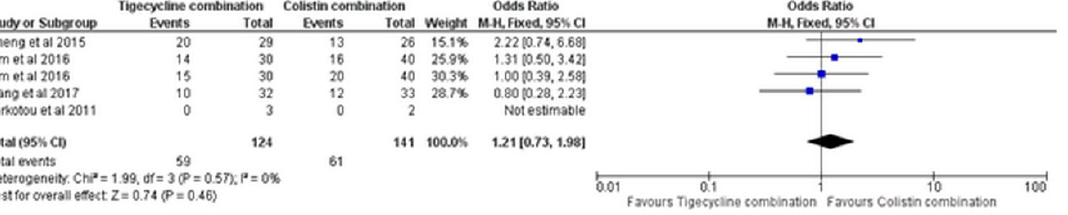
Figure 12. In-hospital mortality of tigecycline combination versus colistin combination [16,19–21].